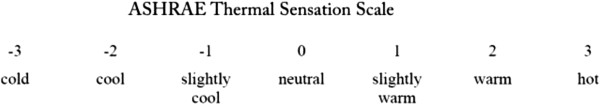
ASHRAE Thermal sensation scale.